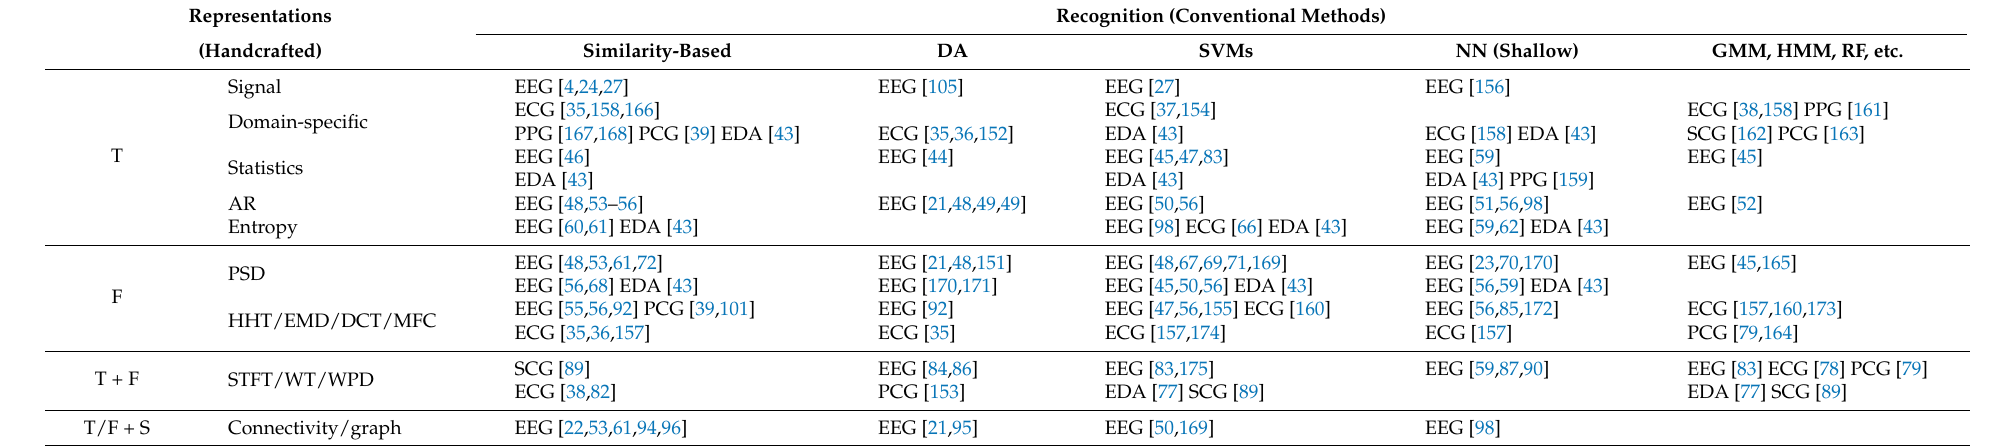
Table 5. Summary of studies using handcraft representations with conventional recognition